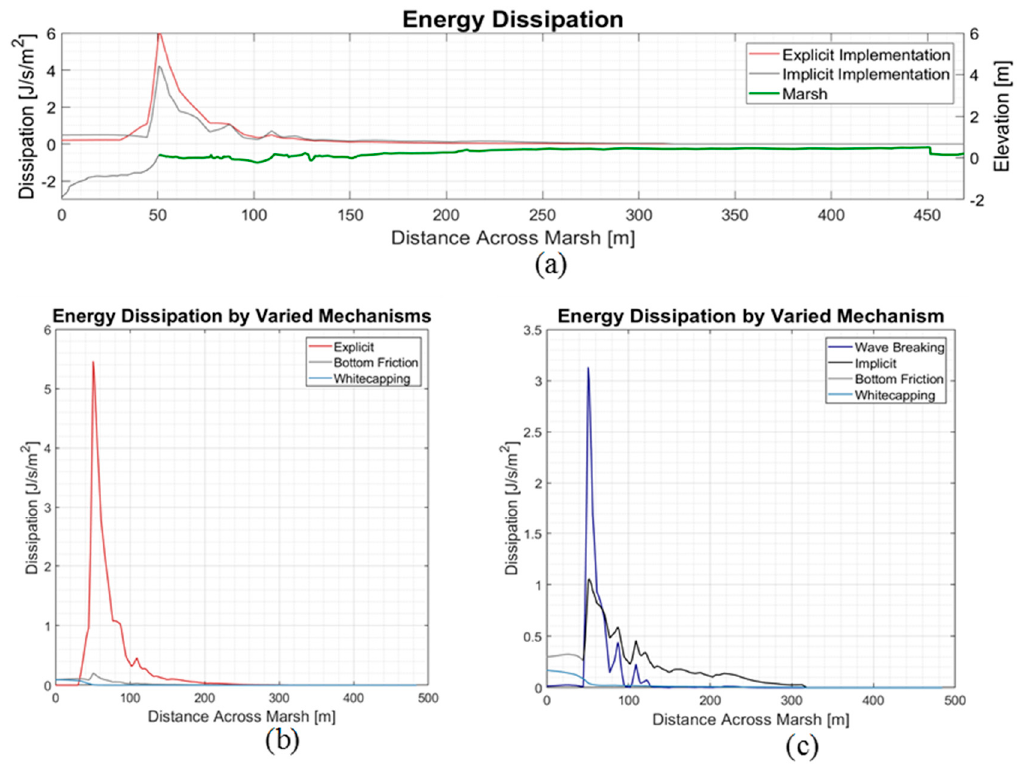
Figure 11. ( a ) Energy dissipation rates for the explicit (red) and implicit (gray) dissipation across the marshland shown in green Panels ( b ) and ( c ) separate the dissipation rates by mechanism (bottom friction (gray), wave breaking (dark blue), whitecapping (light blue), implicit vegetation (black) and explicit vegetation (red)). The explicit representation is shown in panel ( b ) while the implicit representation is shown in panel ( c